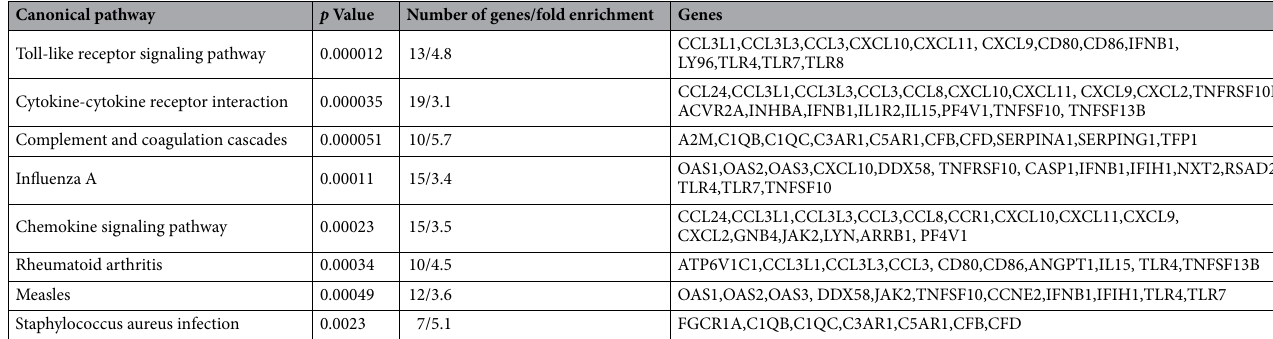
Table 3. KEGG pathways downregulated by Lp299v. *Analysis performed using DAVID 6.8. Clustering Parameters: Threshold:2, EASE: 0.05. p Value Threshold: P < 0.005. † Lp299v = Lactobacillus plantarum 299v.